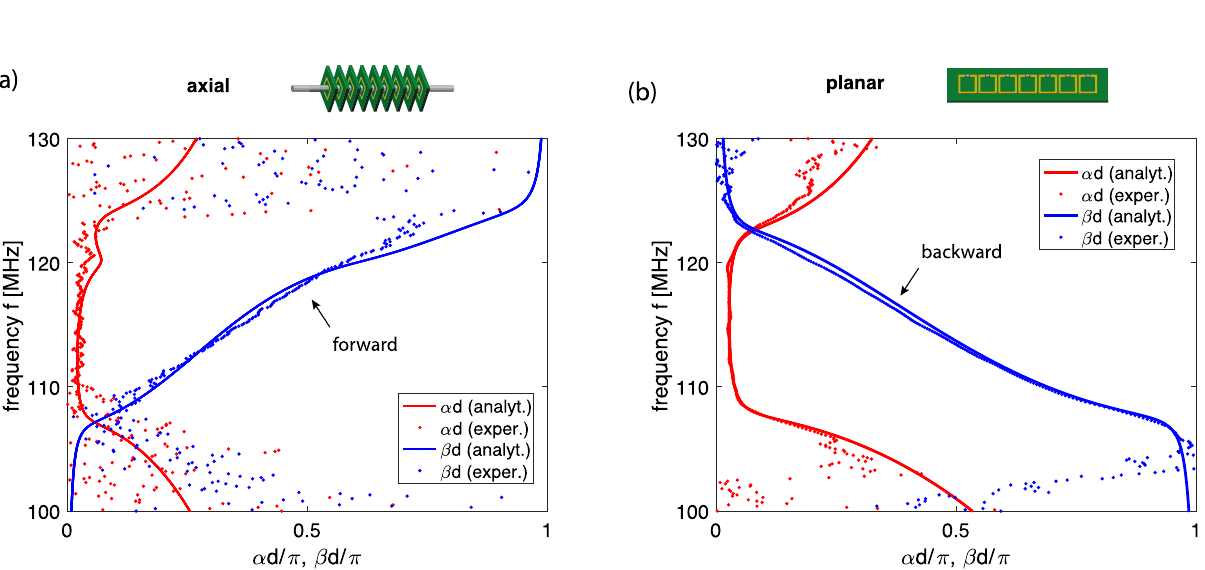
Figure 4. MI dispersion relations for the axial ( a ) and the planar ( b ) array. Red: attenuation constant α vs. ω , blue: propagation constant β vs. ω . Analytical model (solid lines) and experimental data